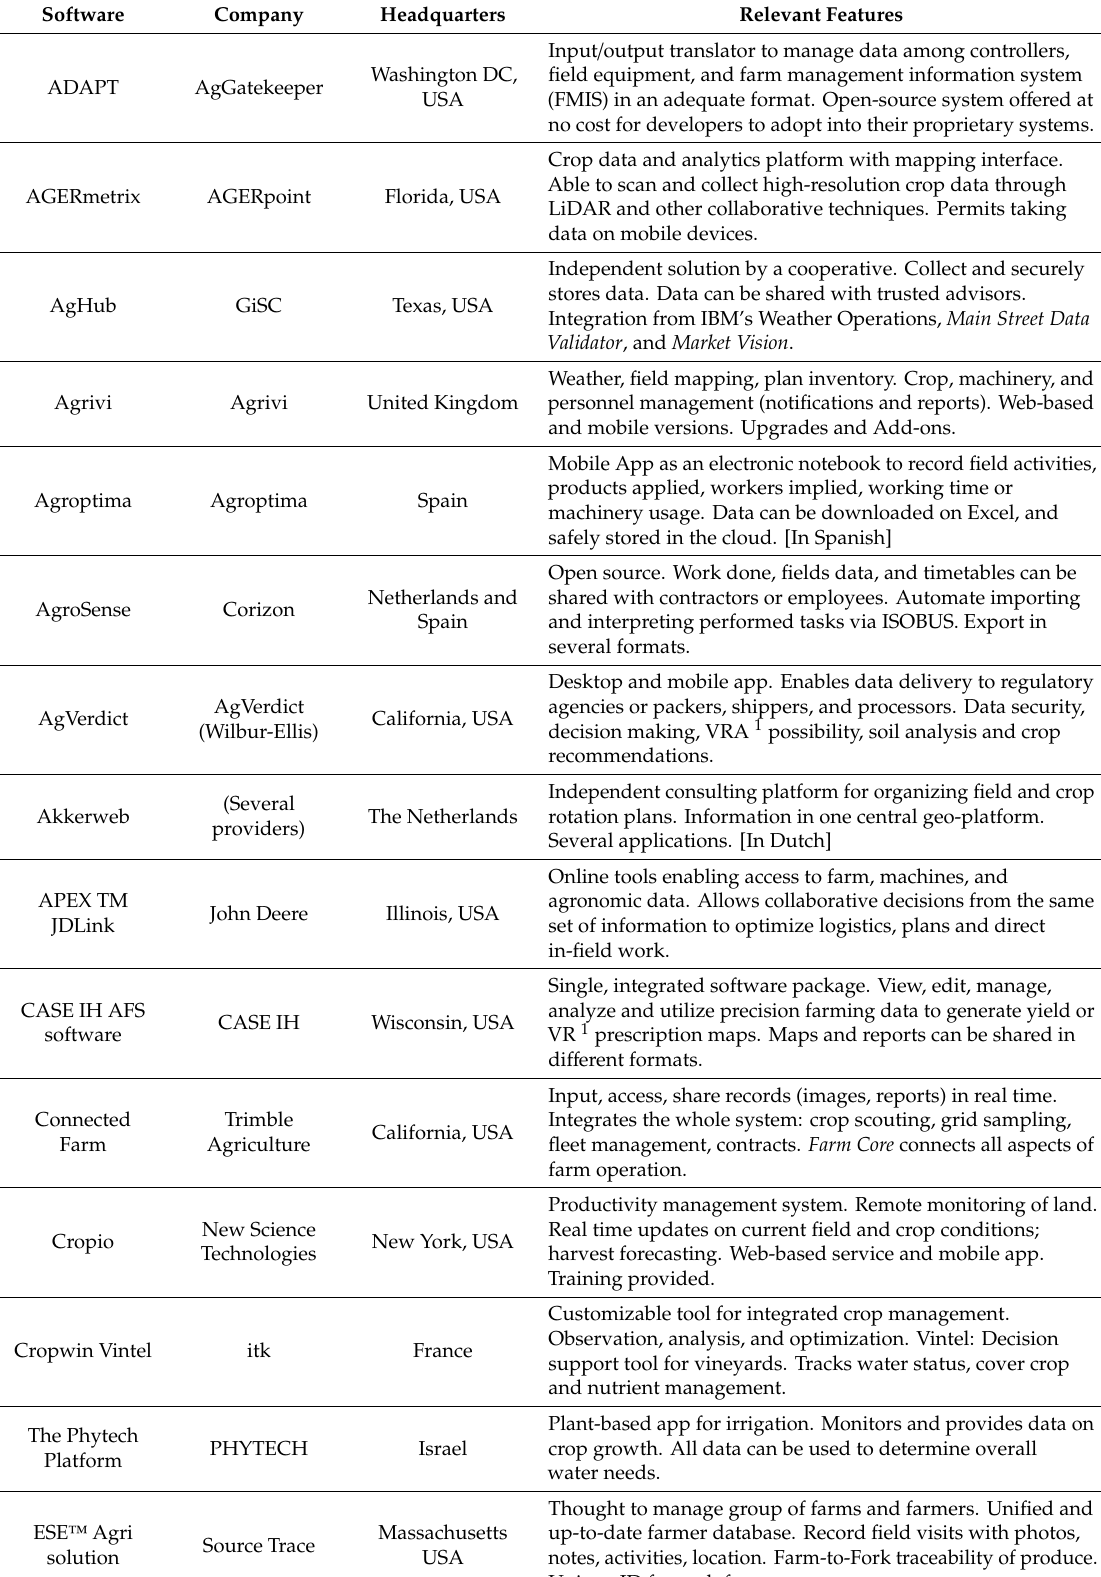
Table 2. Crop data management software applications and their main features